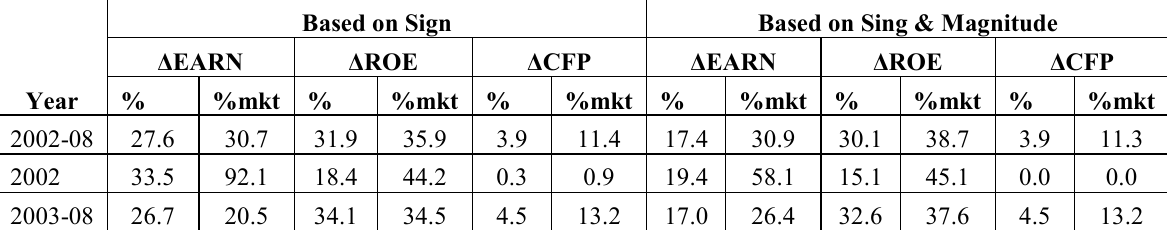
Panel B: Mean market-adjusted returns on accounting hedge portfolio (%) and proportion of the total hedge portfolio market-adjusted returns can be earned by the per-knowledge of accounting information (average for full sample, before and after